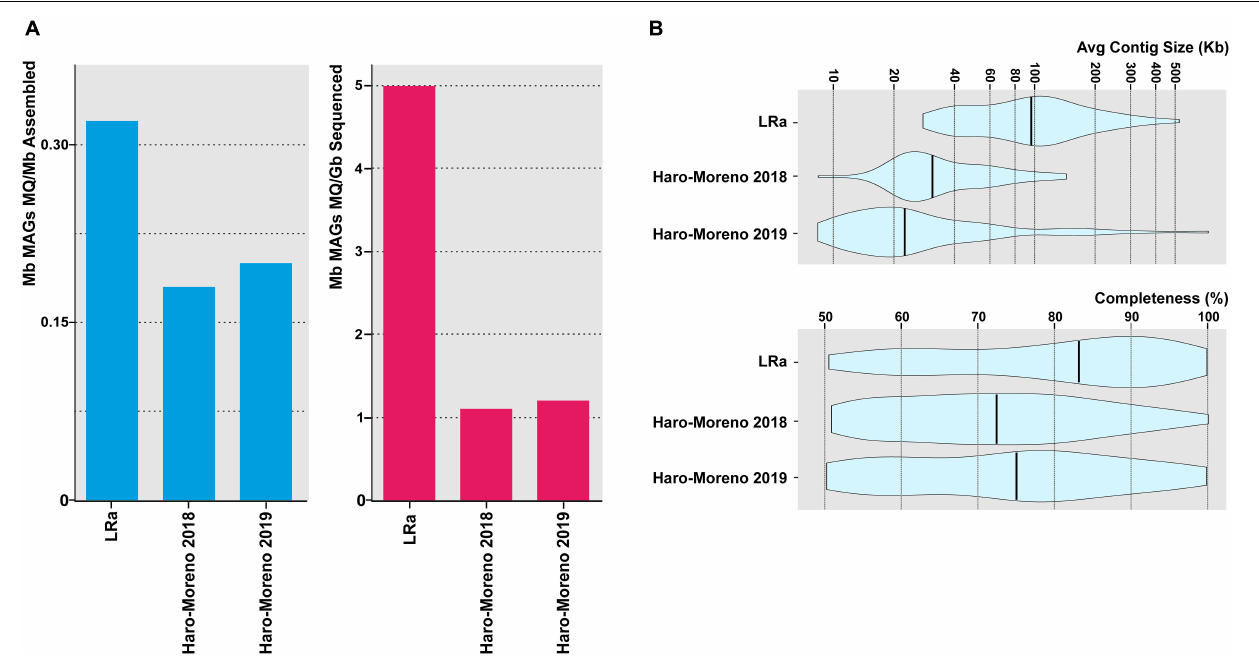
FIGURE 4 | (A) Contribution of medium-quality MAGs ( > 50% complete and < 5% contamination) recovered in this study (LRa) and from two previous reports from the same location in the Mediterranean Sea (Haro-Moreno et al., 2018, 2019). Values are normalized by the assembly size and sequencing effort (blue and red bars, respectively). (B) Violin plots showing the average contig size and the degree of completeness of MAGs described in panel (A)